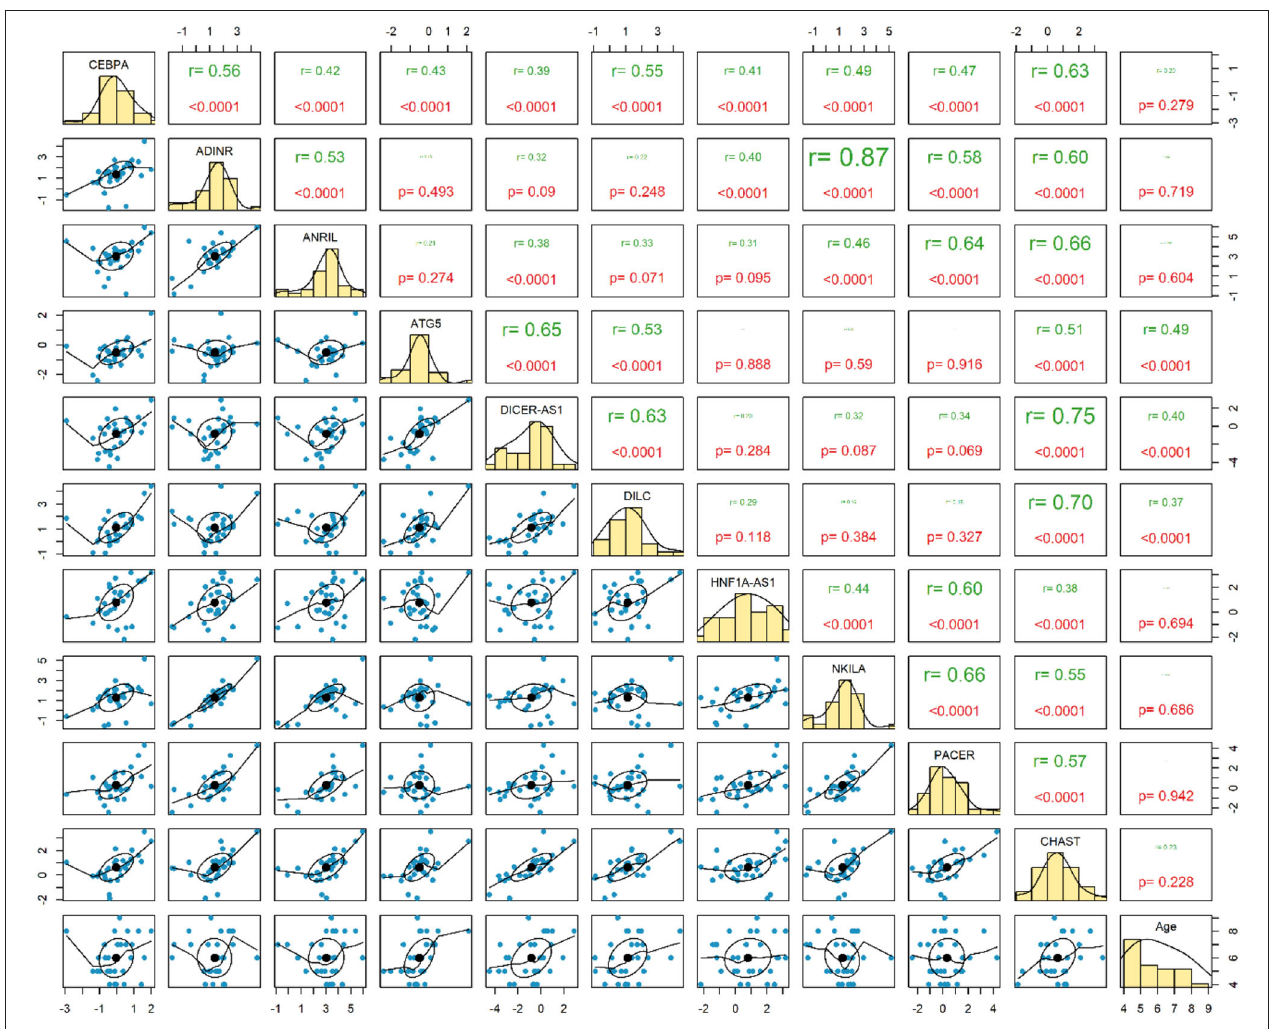
FIGURE 2 | Correlation between expressions of genes among patients with